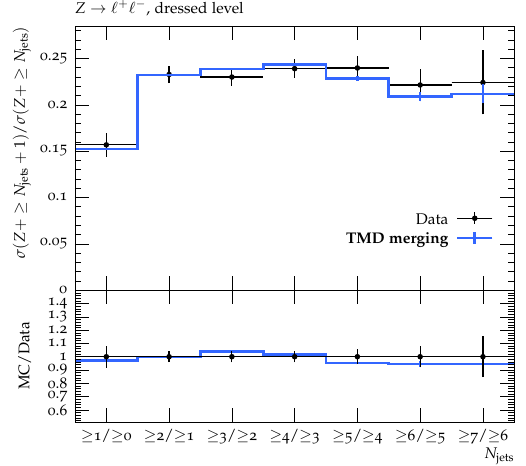
Figure 11 . Ratio for successive inclusive jet multiplicities in the production of a Z -boson in association with jets. Experimental measurements by ATLAS [91] at